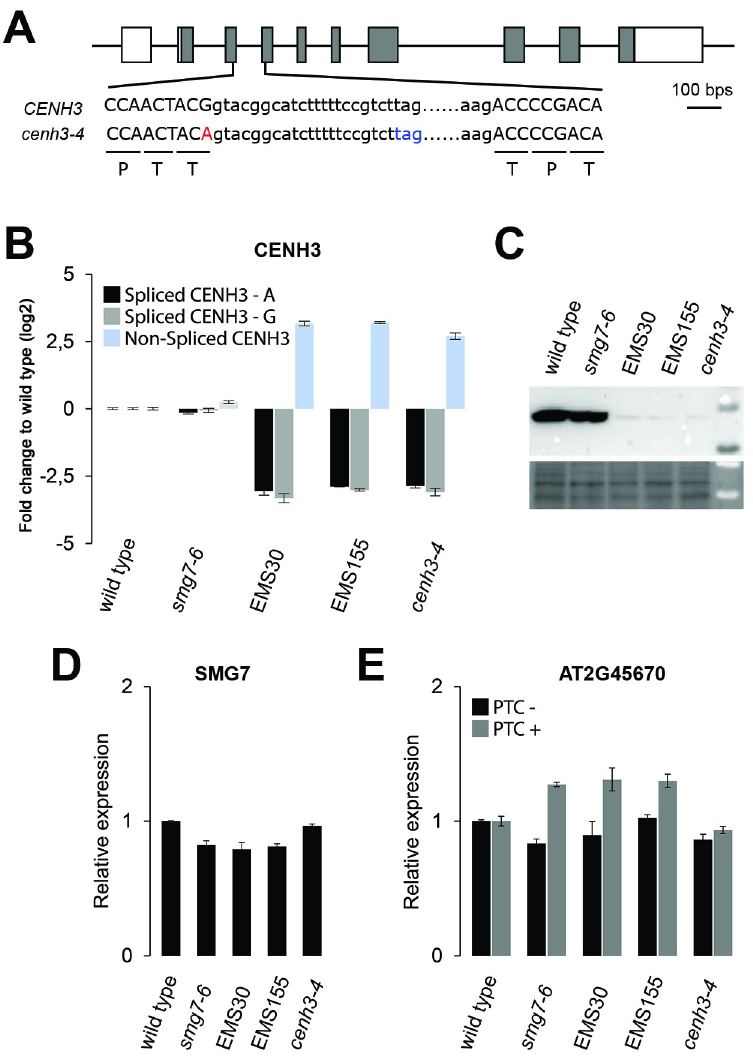
Fig 6. Molecular characterization of the cenh3-4 allele. (A) Diagram of the CENH3 gene with exons marked as boxes. DNA sequence surrounding the intron 3 is shown; capital letters depict exons. Amino acids encoded by canonically spliced mRNA are indicated. The cenh3-4 mutation at the splice donor site of exon 3 is indicated in red, stop codon in the intron of unspliced mRNA in blue. (B) Relative abundance of spliced and unspliced CENH3 mRNA determined by quantitative RT-PCR. Two sets of primers were designed for fully spliced mRNA matching either wild type (CENH3-G) or cenh3-4 (CENH3-A) allele sequences. (C) Western blot detection of total CENH3 protein by anti- CENH3 antibody. Protein loading is shown on a Ponceau-S stained membrane (bottom panel). (D) Abundance of SMG7 mRNA relative to wild type determined by qRT-PCR. (E) NMD efficiency assessed by qRT-PCR analysis of alternatively spliced variants of the AT2G45670 gene with or without a premature termination codon (PTC) relative to wild type. Error bars in (B), (D) ad (E) represent standard deviations from 3 biological replicas.